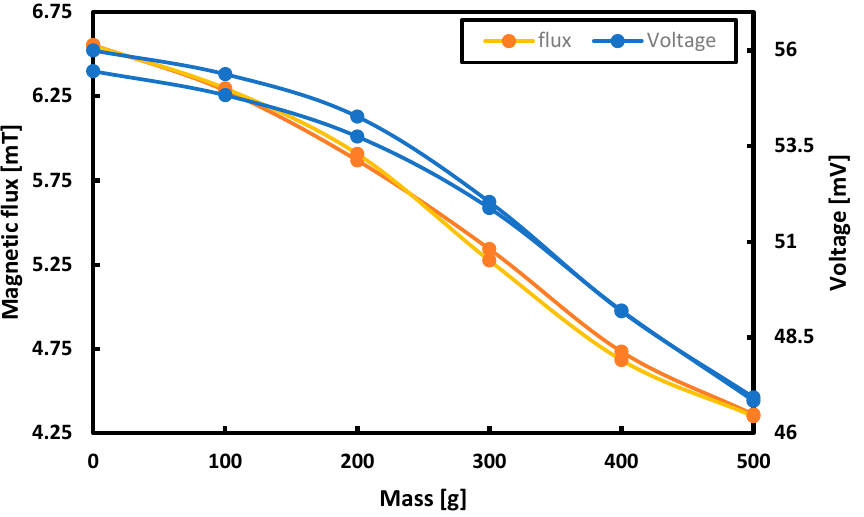
Figure 8. The results of measurements of voltage and magnetic flux for successive masses loading the tested plate.